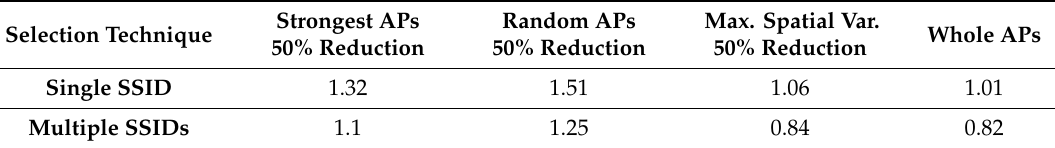
Figure 15. The proposed technique with the Fuzzy C-mean approach. Table 6. The distance error of the C-means-based proposed system versus a single SSID.